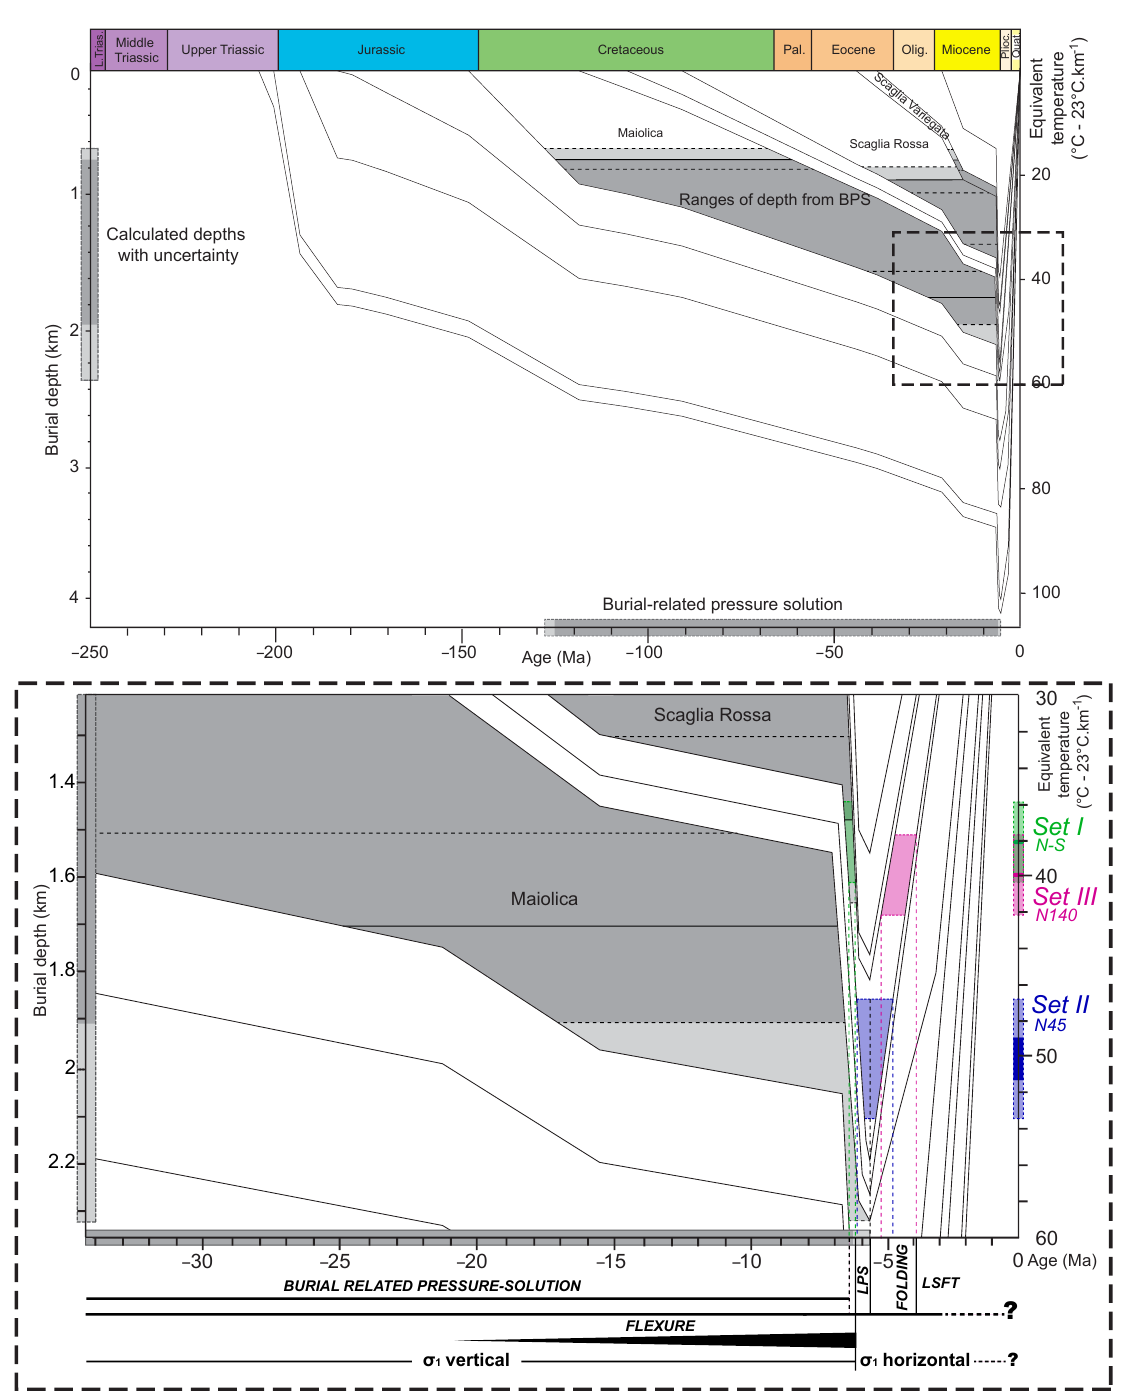
Figure 6. Burial model constructed considering thickness from stratigraphic and well data corrected for chemical and physical compaction. The range of depths reconstructed from BPS roughness inversion (with uncertainty shaded in light grey) are reported for each formation as grey levels. The corresponding timing and depth of active dissolution are reported on the x axis and left y axis, respectively. The results of clumped isotope analysis (i.e., temperatures of precipitation of vein cements at thermal equilibrium with the host rock) are reported on the right y axis. The timing of the deformation is reported on the right-hand side in the insert. Onsets of LPS, folding stage and LSFT are deduced from the results of the roughness inversion process applied on sedimentary stylolites, as well as from clumped isotope